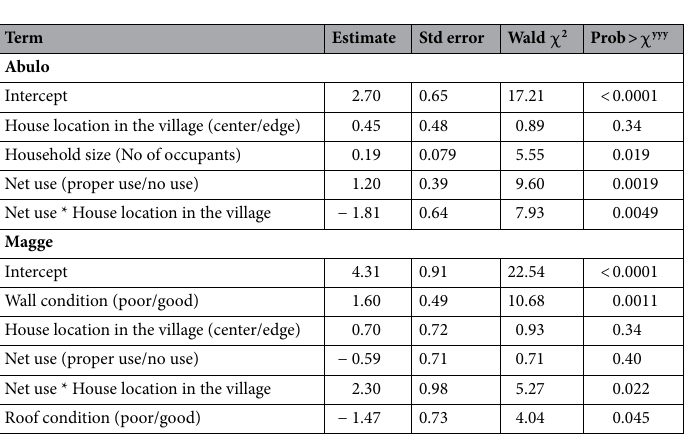
AIC value of 218 (Table 3). In Magge, only the location of the house in the village in both the overall (AIC = 259; Supplementary Table S5) and the final model (AIC = 230; Table 3) was found to be a significant predictor of malaria prevalence.